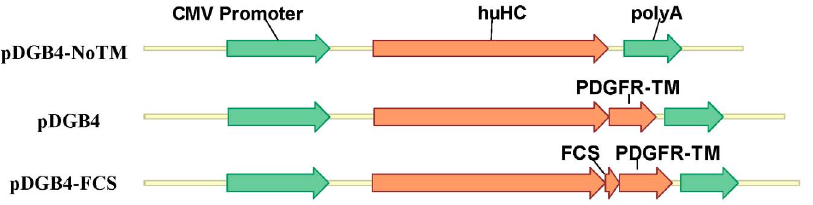
Figure 3. Schematic comparison of expression vectors. pDGB4 contains a trans-membrane domain at the 3 9 -end of heavy chain in frame and the antibody expressed is displayed on cell surface. pDGB4-noTM is derived from pDGB4 by deletion of the trans-membrane domain, and the antibody expressed is in soluble version. pDGB4-FCS can simultaneously express both displayed and secreted antibody molecules because of the presence of Furin cleavage site (FCS) between heavy chain and trans-membrane domain.